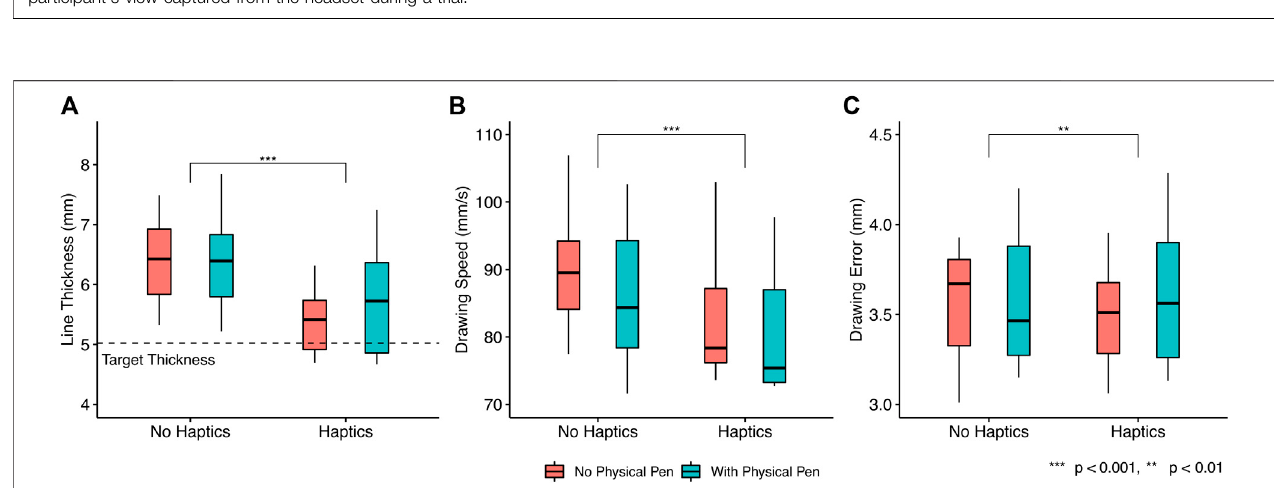
FIGURE 9 | Results from the user study: (A) Participants draw lines that are closer to the target thickness (5 mm) with haptic feedback. (B) Users slow down signi fi cantly when haptic feedback is provided. (C) Users produce less 2D error when drawing with haptic feedback.